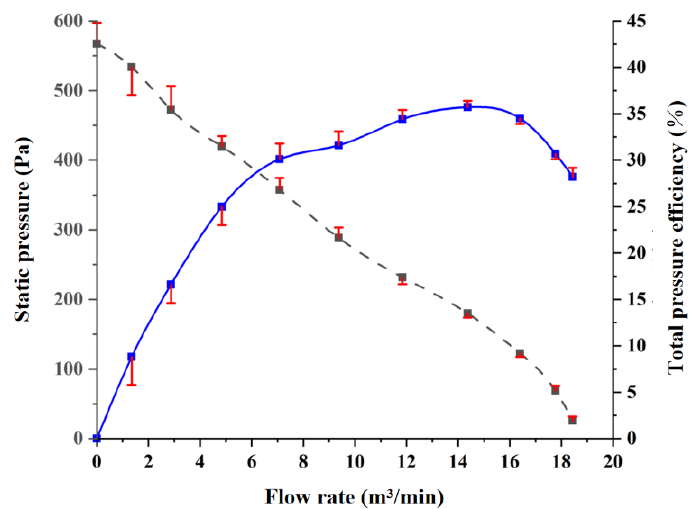
Figure 6. Comparison of experimental and predicted values.